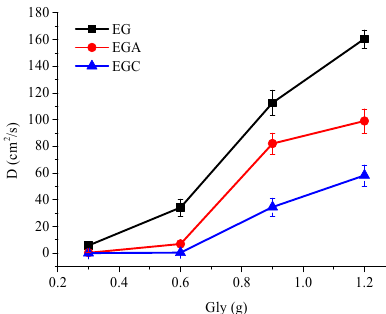
Figure 4. Alteration of diffusion coefficient ( D ) values of CEOs released from films EG, EGA, and EGC to ethanol with the increase of glycerol from 0.3 to 1.2 mL.